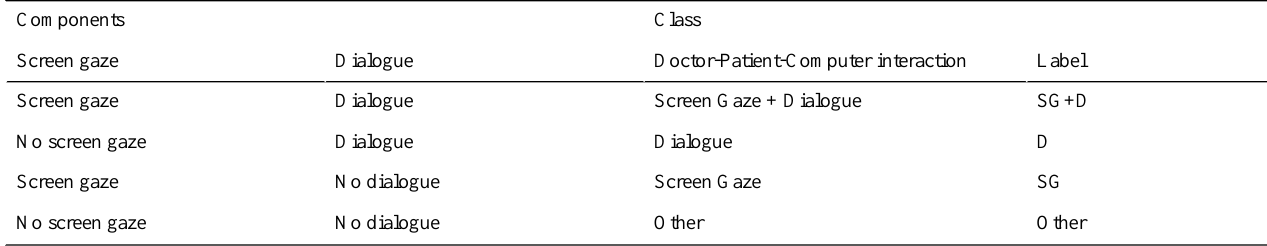
Table 1. Four classes of doctor-patient-computer